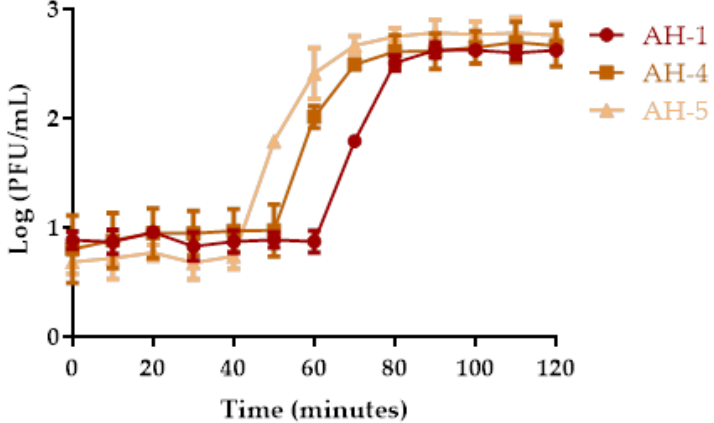
Figure 2. One-step growth curves of phages AH-1, AH-4, and AH-5 in the presence of A. hydrophila as the host. Values represent the mean of three independent experiments, and error bars represent the standard deviation.